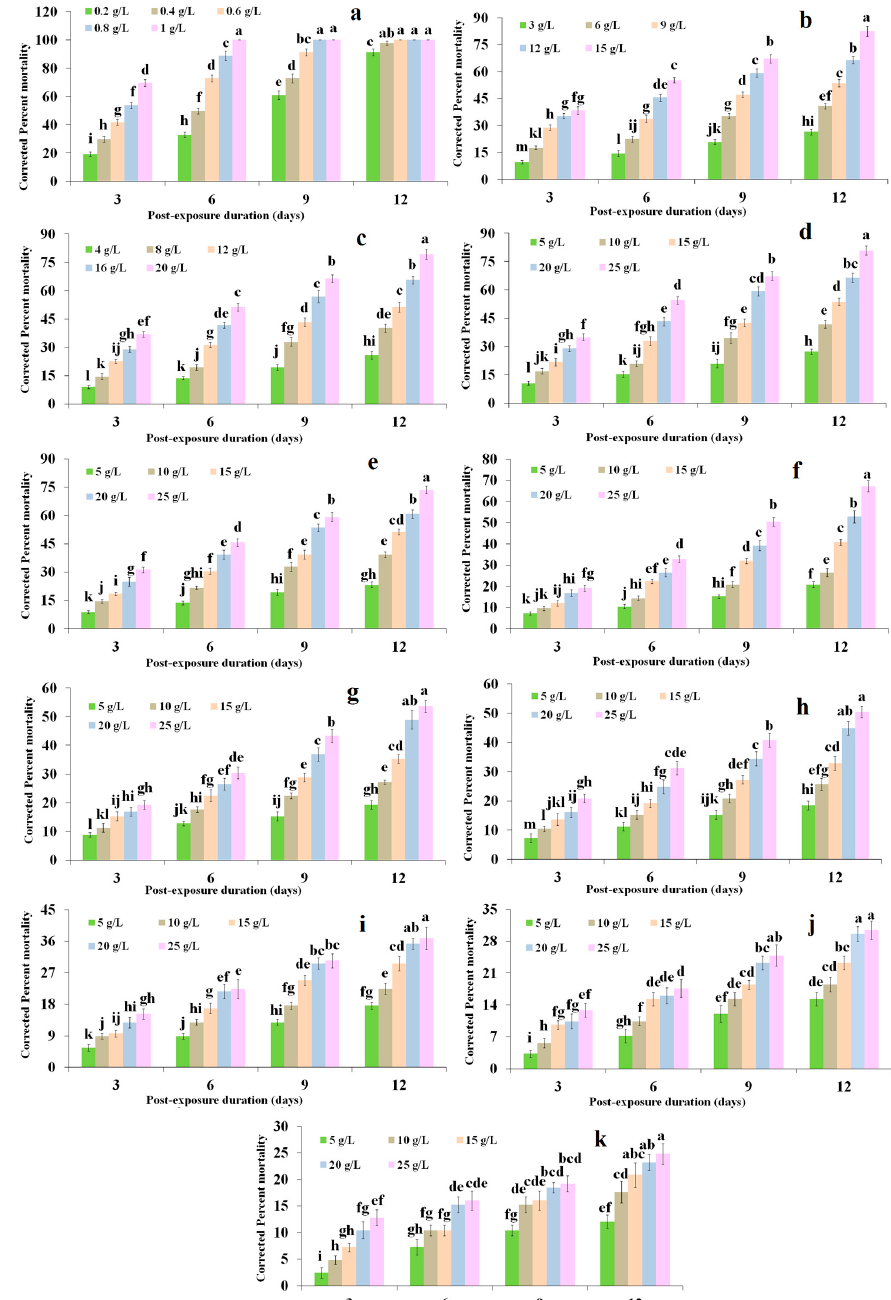
Figure 1. Percent corrected cumulative dose-mortality response of R. ferrugineus larvae against ( a ) coumarin; ( b ) ethyl cinnamate; ( c ) diniconazole; ( d ) isoeugenol; ( e ) coumarin 6; ( f ) asarone; ( g ) eugenol; ( h ) coniferyl aldehyde; ( i ) rosmarinic acid; ( j ) methyl isoeugenol; and ( k ) methyl eugenol. Bars (means ± SE) followed by different letters are significantly different. (Fisher’s LSD test, α = 0.05).